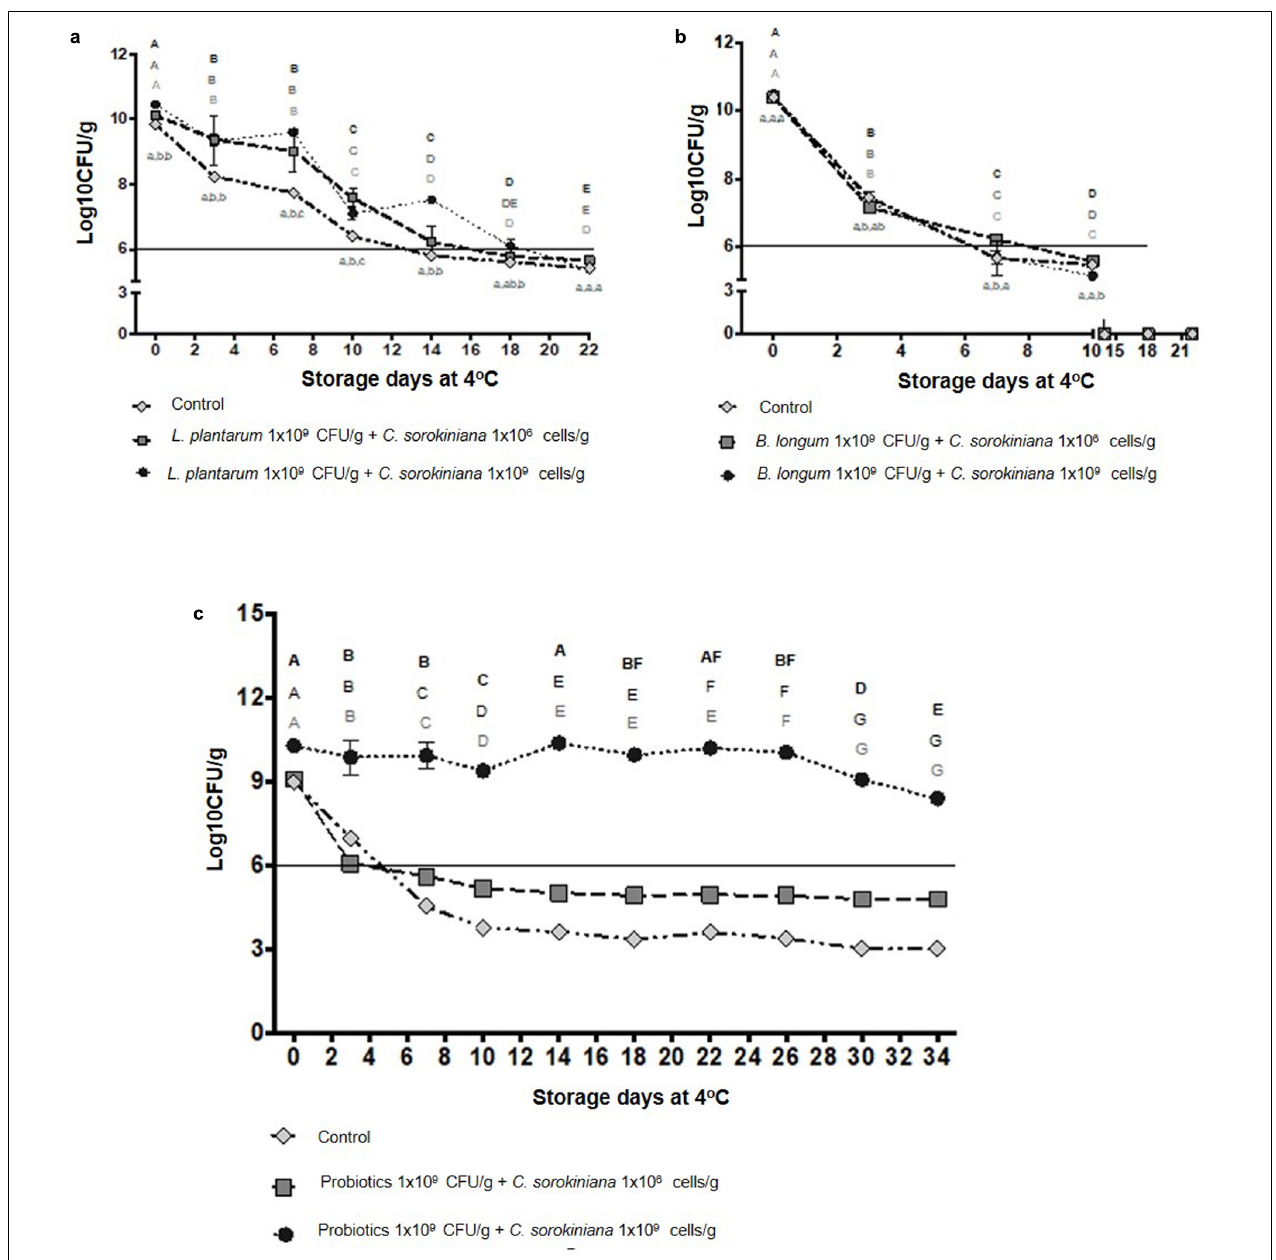
FIGURE 2 | Viability of Lactobacillus plantarum and Bifidobacterium longum in combination with Chlorella sorokiniana in a dairy product. (a) L. plantarum viability (days) alone and in combination with C. sorokiniana . (b) B. longum viability (days) alone and in combination with C. sorokiniana . (c) L. plantarum and B. longum viability (days) with and without C. sorokiniana . Lowercase letters indicate statistical significances between treatments at a specific time. Capital letters indicate statistical significances in treatment over time. Gray letters represent the control, black letters indicate L. plantarum or B. longum (1 × 10 9 CFU/g) + C. sorokiniana (1 × 10 6 Cells/g), and bold black represent L. planatrum or B. longum (1 × 10 9 CFU/g) + C. sorokiniana (1 × 10 9 Cells/g). Data were analyzed by two-way ANOVA with subsequent Fisher ìs LSD test using GraphPad Prism